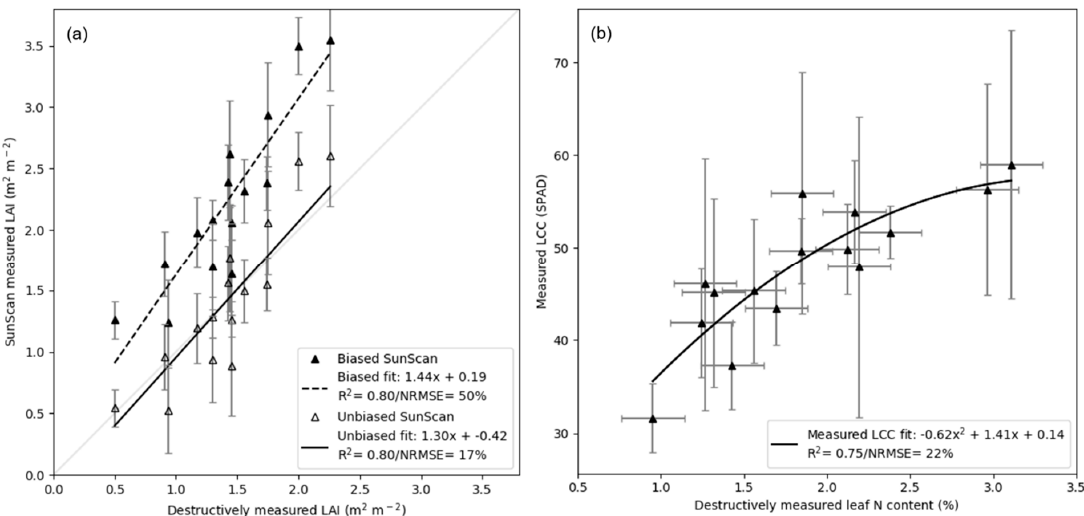
Figure 2. Comparison of in situ non-destructive to mean destructive sample measurements acquired on three dates (25 May, 13 June and 4 July 2018) for five winter wheat trial plots, including ( a ) in situ measured Leaf Area Index (LAI) (SunScan) compared to LAI measured from destructive samples and ( b ) chlorophyll meter (soil plant analyses development (SPAD)) measured leaf chlorophyll content (LCC) compared to leaf nitrogen content measurements. Note: Fit line (black line) is defined using reduced major axis where y -axis error bars are derived from the standard deviations of non-destructive measurements and x -axis error bars represent the mean range between two destructive samples that were analysed for each plot.